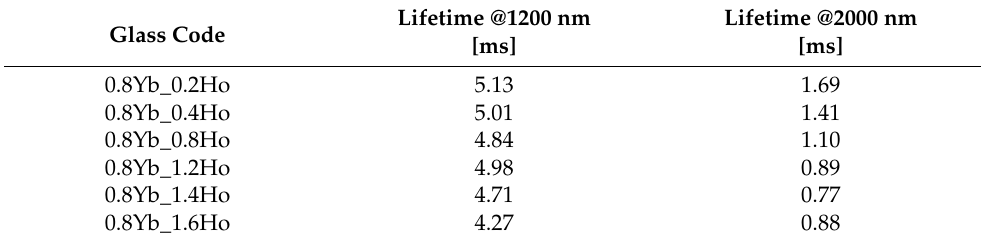
Table 3. Calculated lifetimes of 5 I 6 and 5 I 7 levels in Ho 3+ ions.